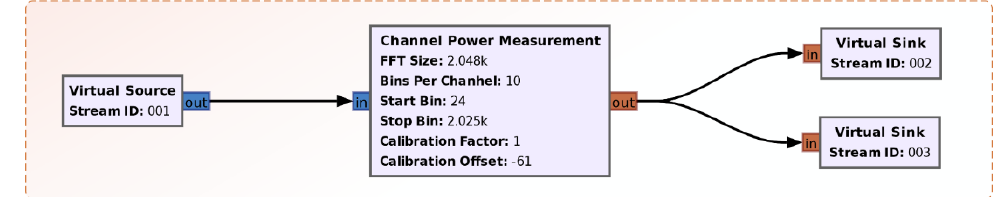
Figure 4. FFT calculation method in GNU Radio.